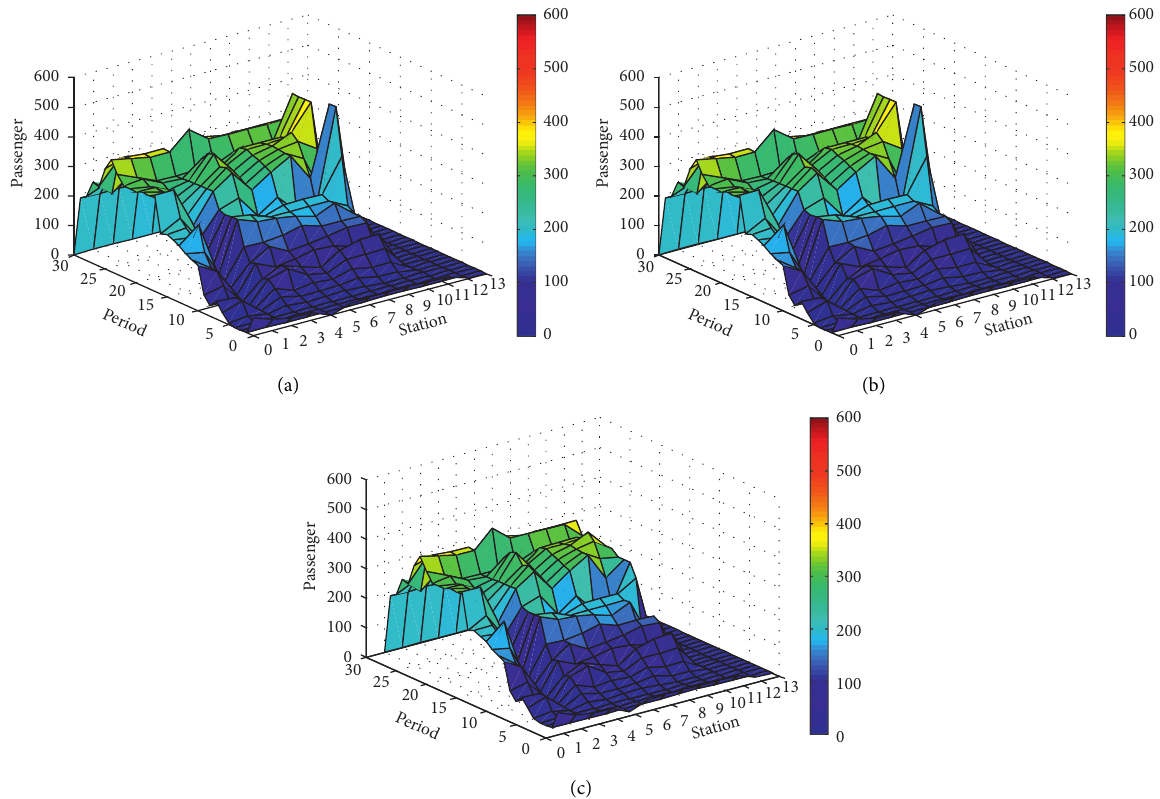
Figure 13: The number of controlled passengers with different models. (a) Solution B. (b) Solution C. (c) Solution